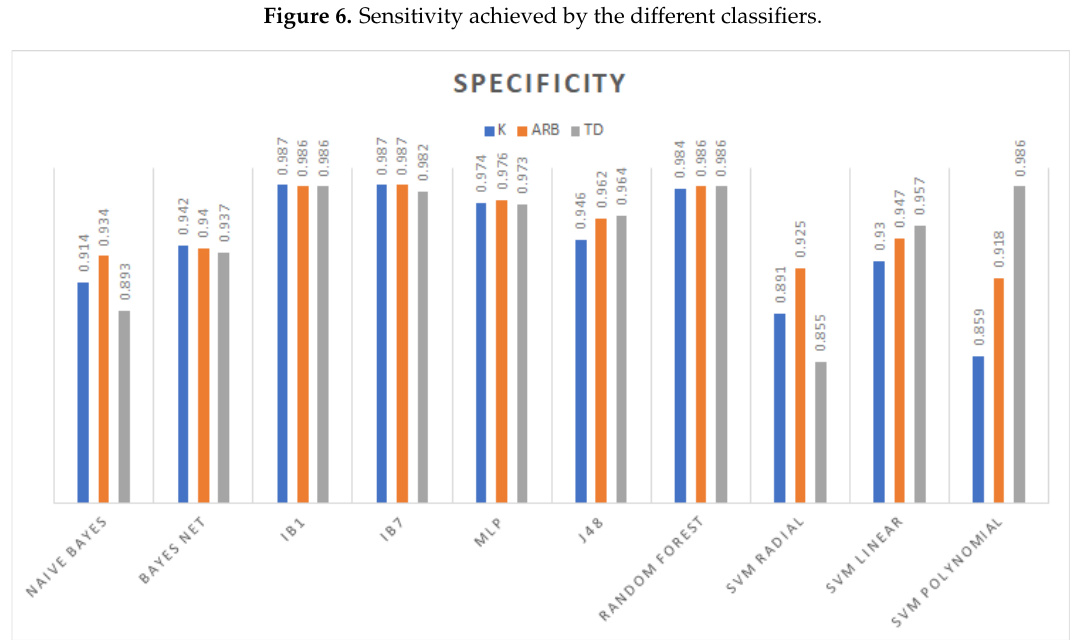
Figure 7. Specificity achieved by the different